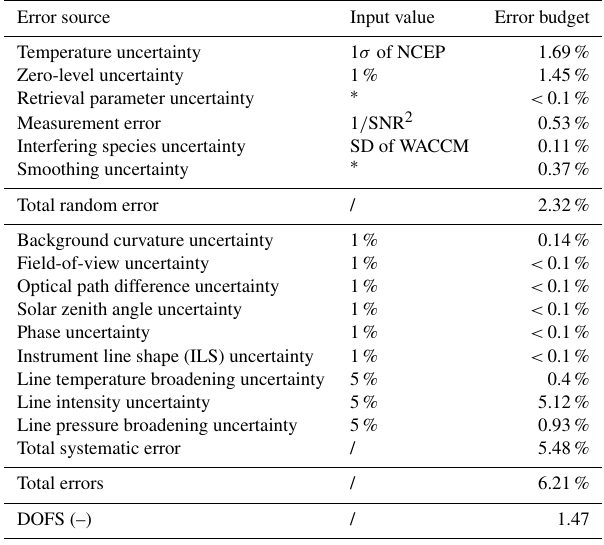
Table 1. Error budget and degrees of freedom (DOFS) for signal of a randomly selected C 2 H 6 troDMF retrieval over Hefei, eastern